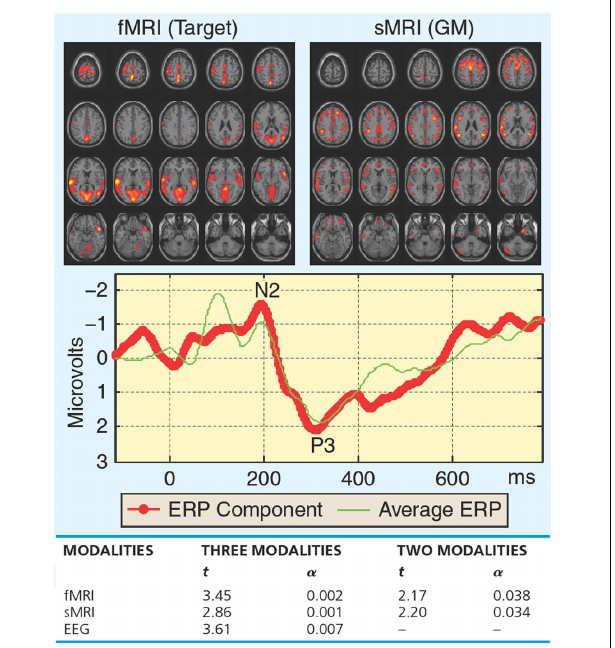
FIGURE 2 | Functional magnetic resonance imaging/EEG/sMRI fusion by mCCA from Correa et al. (2010a): a set of associated components estimated by mCCA that showed significantly different loading for schizophrenia patients versus controls, as well as the t -test comparison between three-way and two-way